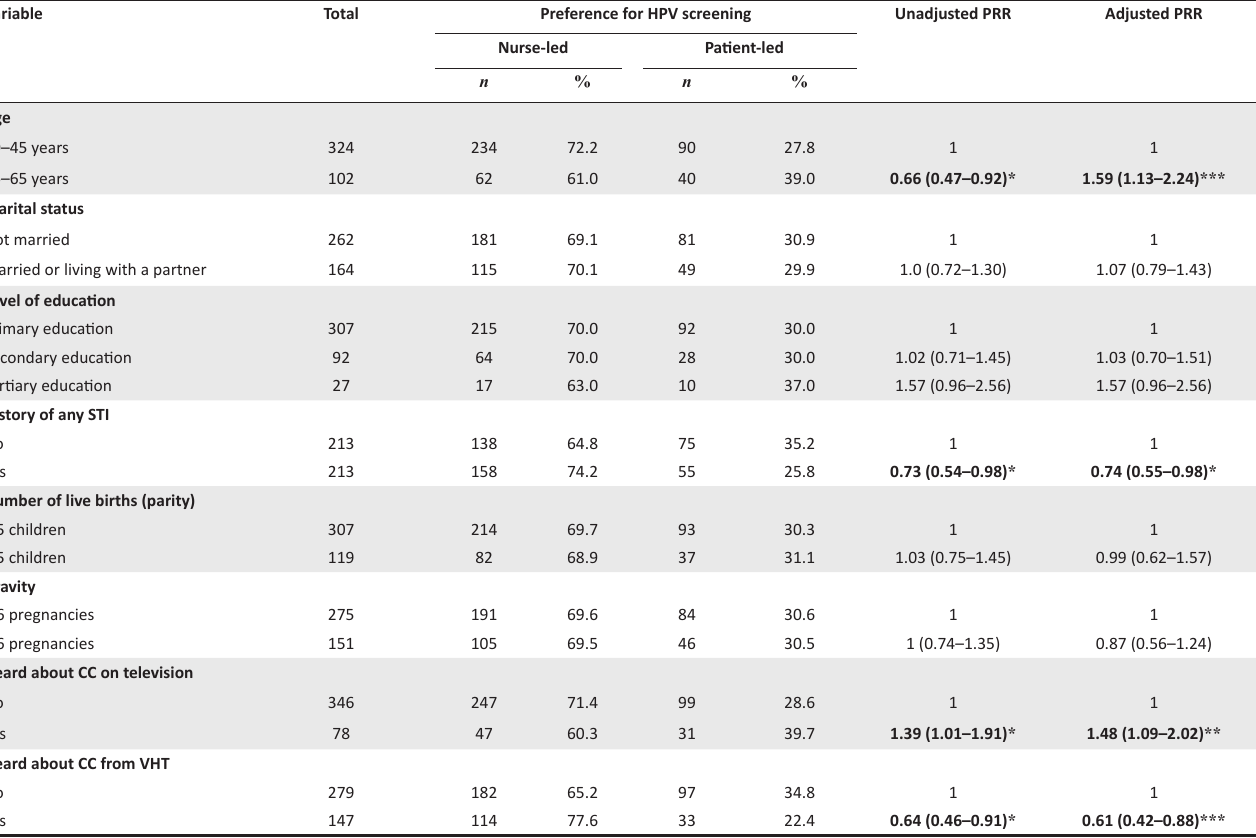
TABLE 4: Prevalence risk ratios of factors associated with preference for human papilloma virus sample collection procedure among women living with HIV at a rural HIV clinic.